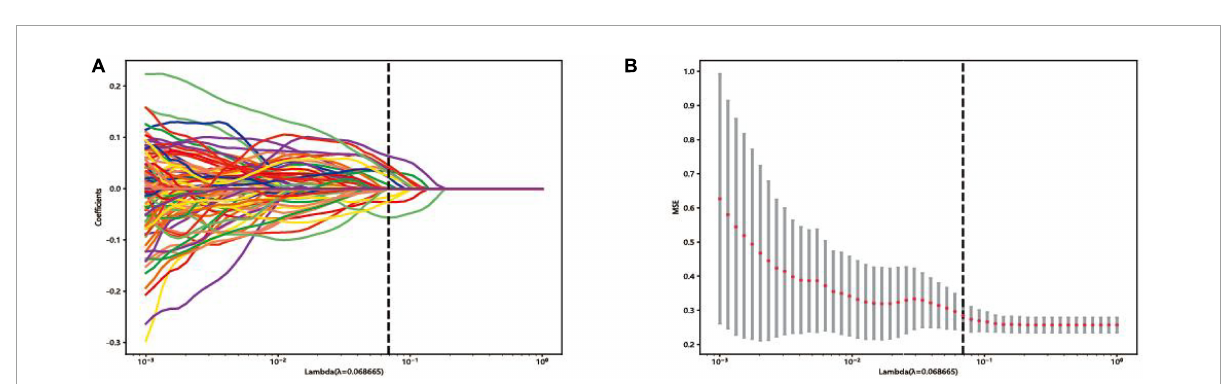
FIGURE2 The flowchart of the ensemble deep learning model.